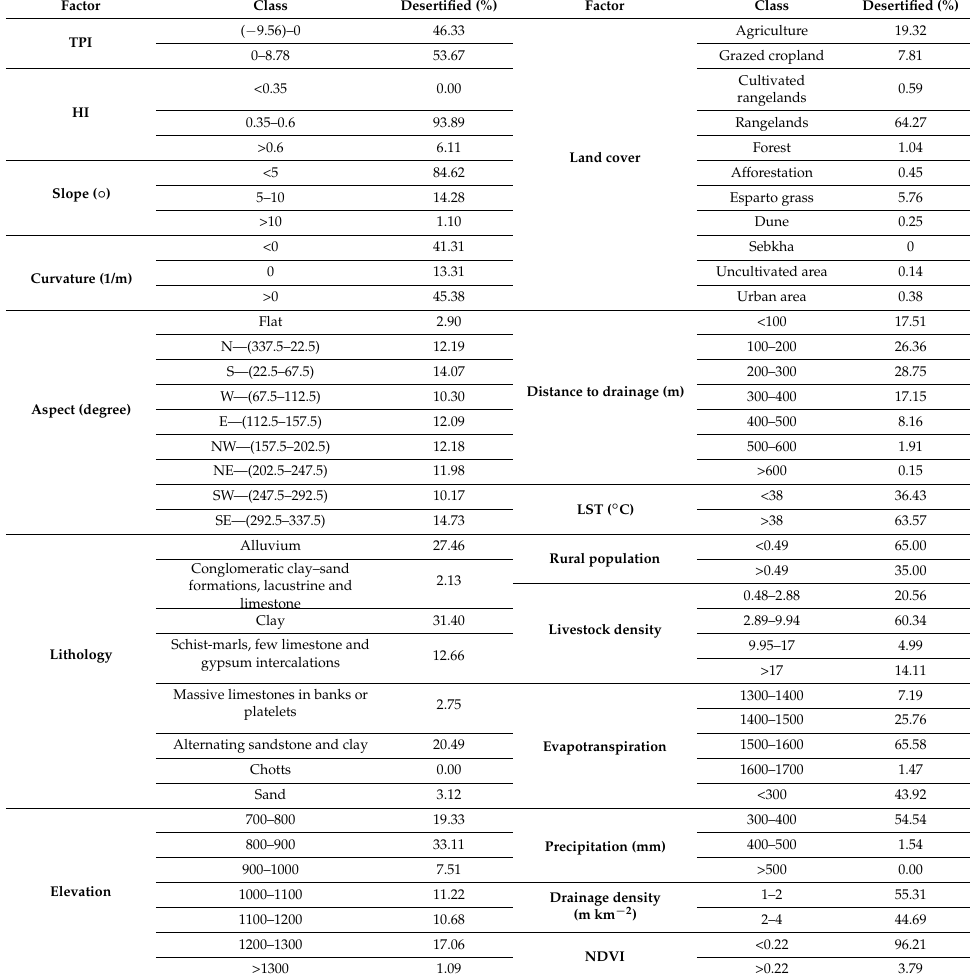
Table 1. Evaluation of the relationships between the desertified area, represented by the training and validation dataset, and desertification-predictive factors. LST: land surface temperature; TPI: topographic position index; HI: hypsometric integral; NDVI: normalized difference vegetation index.